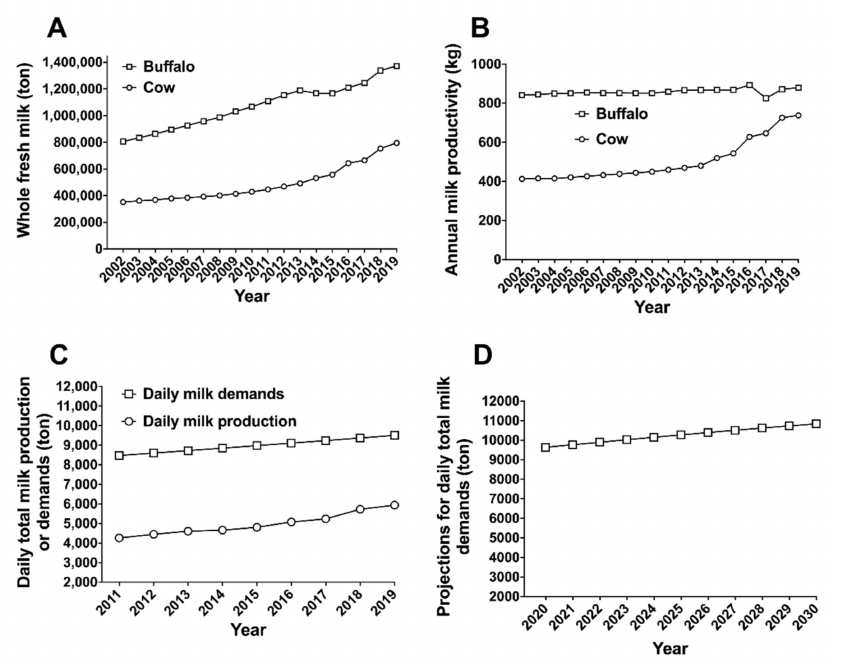
Figure 2. Status of milk production in Nepal (MOALD, 2017; MOALD, 2019) [15,16]. ( A ): Annual whole fresh milk production in ton for 2002–2016 (solid line, (cid:3) : buffalo milk; solid